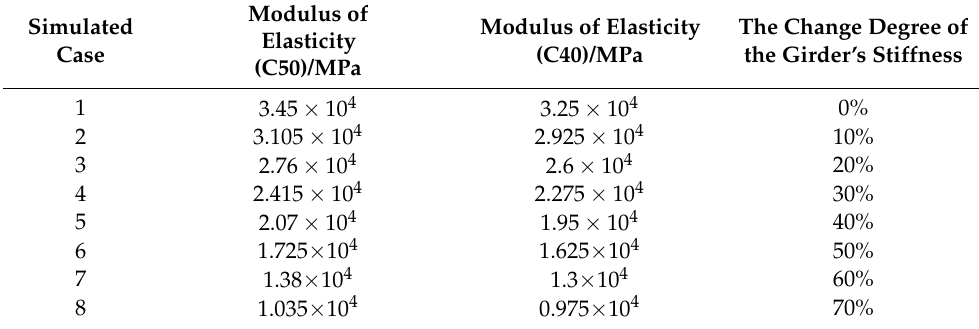
Table 4. Value of theoretical elastic modulus of the girder in each working condition.